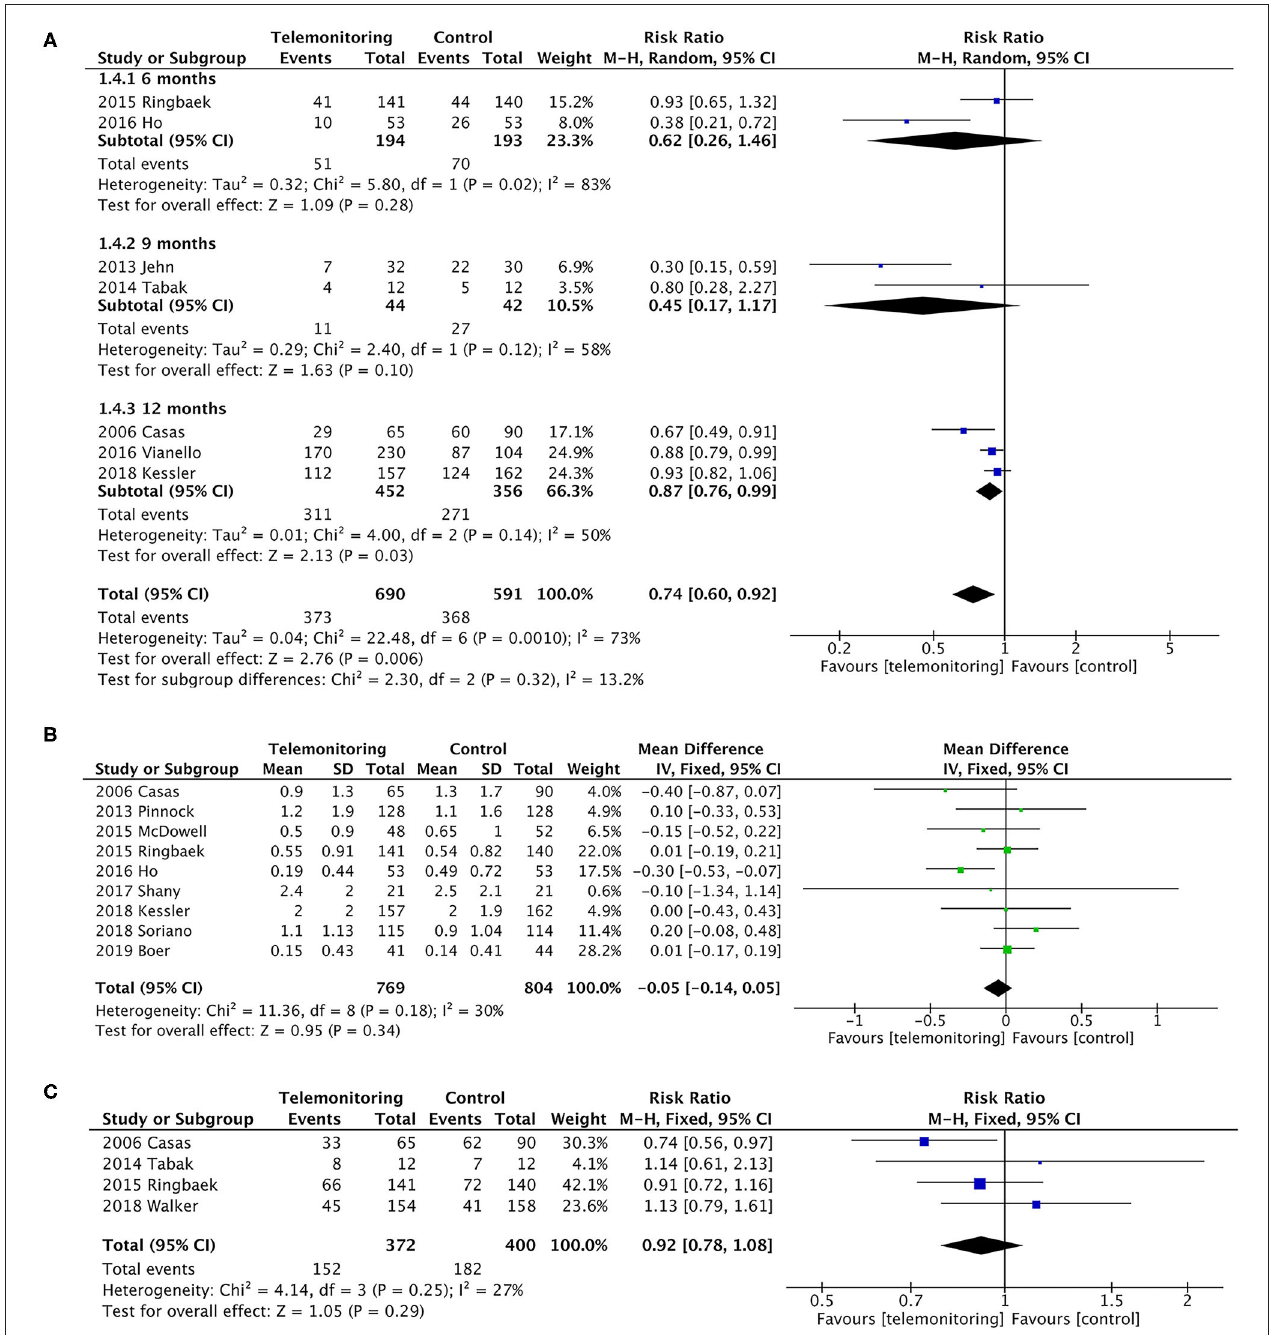
FIGURE 4 | A meta-analysis of readmissions. (A) Exacerbation-related readmissions (subgroup analysis with observation period). A sensitivity analysis using the fixed-effect model resulted in a similar effect size [RR = 0.81, 95% CI (0.74–0.88)] compared to random-effects modeling. One study (Soriano et al.) (9) could not be included in the meta-analysis for it only collected the number of participants who have at least one exacerbation (ER visit or hospitalization) in the past 12 months, resulting in the failure of exacting the required data. Subgroup analysis. In the subgroup in which follow-up duration was 6 or 9 months, it did not reduce readmissions [ P = 0.28, RR = 0.62, 95% CI (0.26, 1.46) and P = 0.10, RR = 0.45, 95% CI (0.17, 1.17), respectively]. Statistically, heterogeneity was found in both subgroups ( I ² = 83% and 58%). However, the subgroup of 12 months showed a greater reduction on readmissions [ P = 0.03, RR = 0.87, 95% CI (0.76, 0.99), I ² = 50%]. Additionally, a sensitivity analysis was performed for the primary outcome to test an overall pooled effect. The results were no different between fixed and random statistical effects (RR = 0.81; P = 0.000). (B) The rate of exacerbation-related readmissions. (C) All-cause readmissions. Low heterogeneity was found ( P = 0.29, I 2 = 27%).